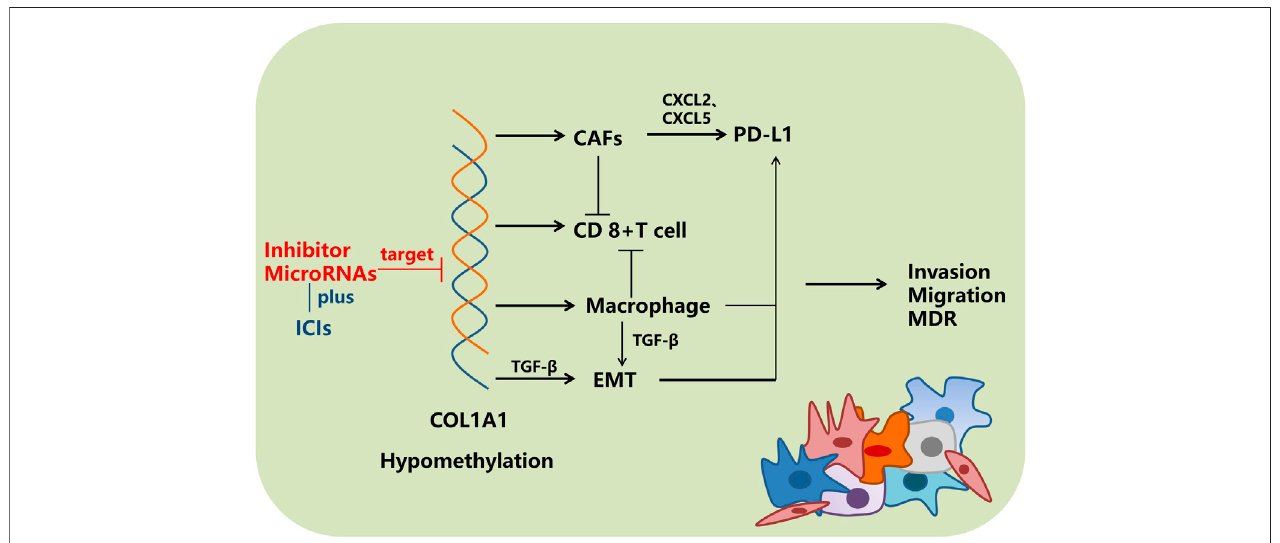
FIGURE 10 | Overview of the regulatory mechanism of COL1A1. MDR: multidrug